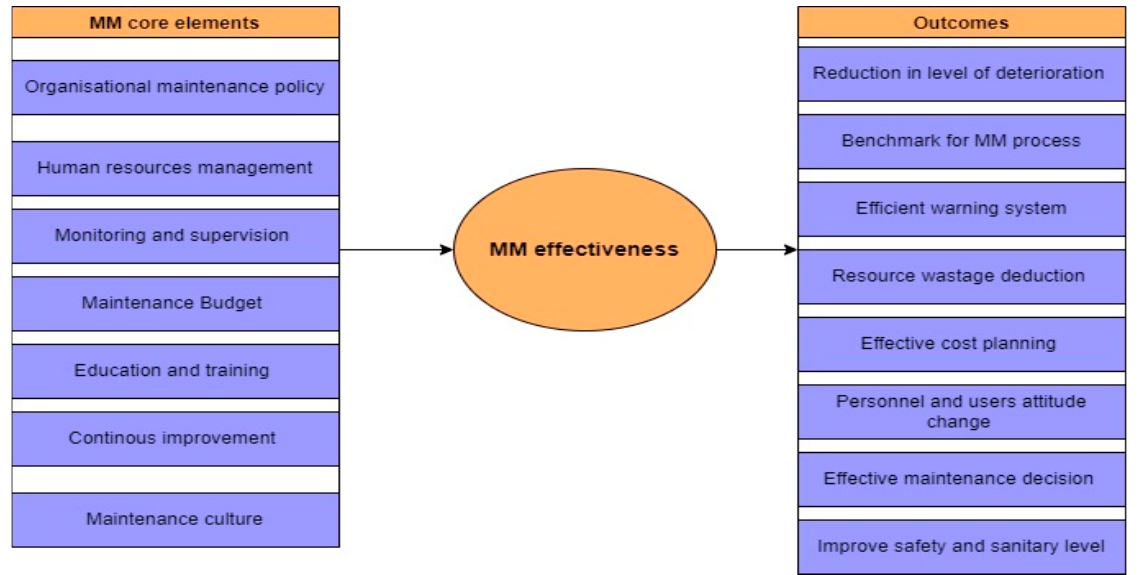
Figure 2. Culture-based maintenance management concept for public buildings.